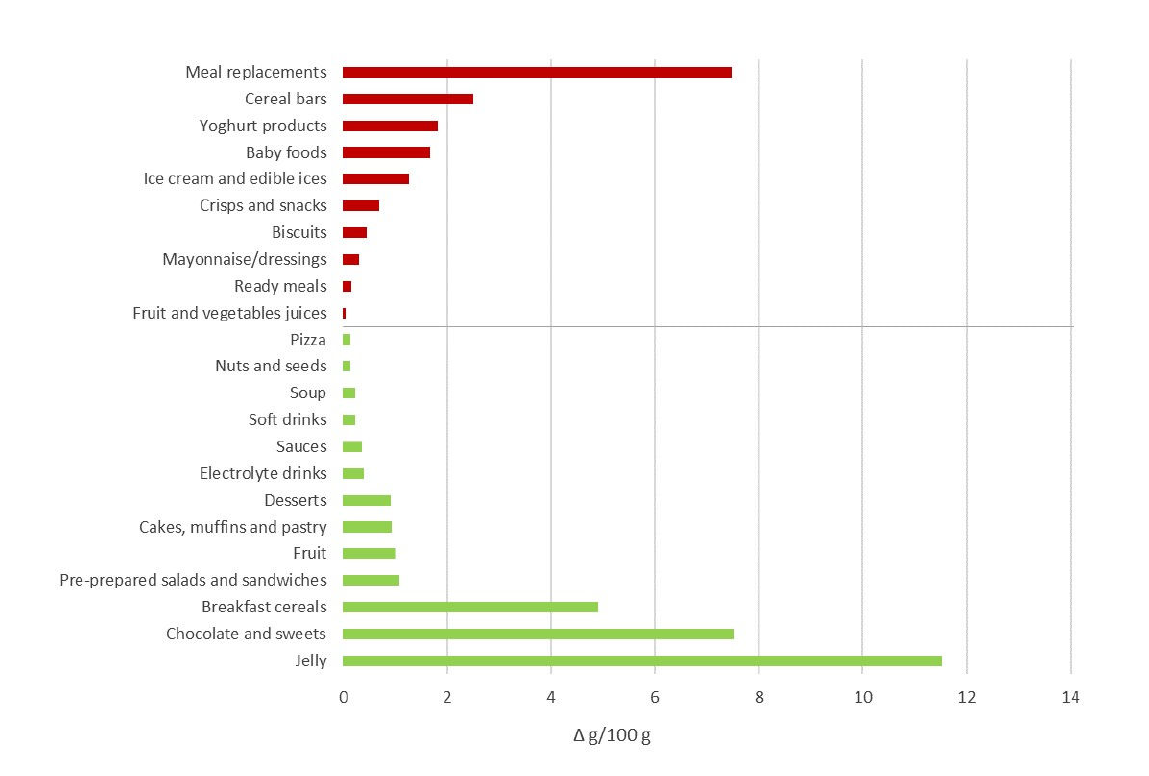
Figure 2. Trends in sales-weighted mean free sugar content (g / 100 g or mL) in selected food categories between 2015 and 2017. The red bars indicate the increases in mean free sugar content in 2017 compared to 2015, while green show the